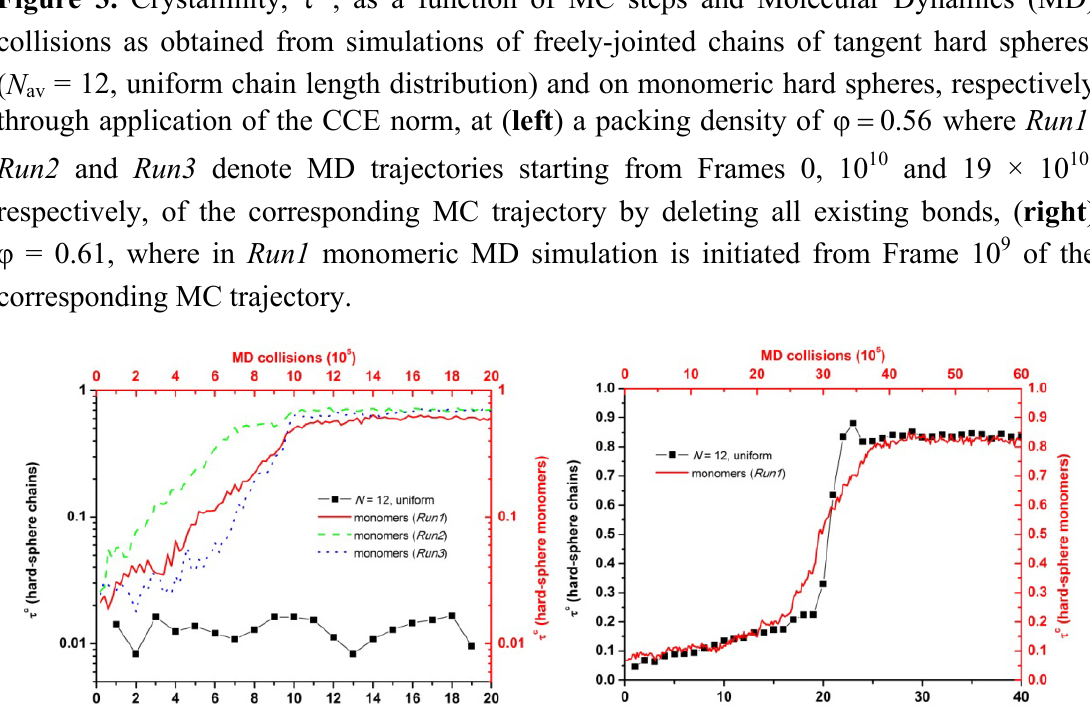
Figure 4. Crystallinity (degree of ordering), τ c , as a function of packing density, , for freely-jointed chains of tangent hard spheres ( N = 12) and for hard sphere monomers. Vertical green and blue dotted lines indicate the freezing ( φ respectively, for hard sphere monomers of uniform